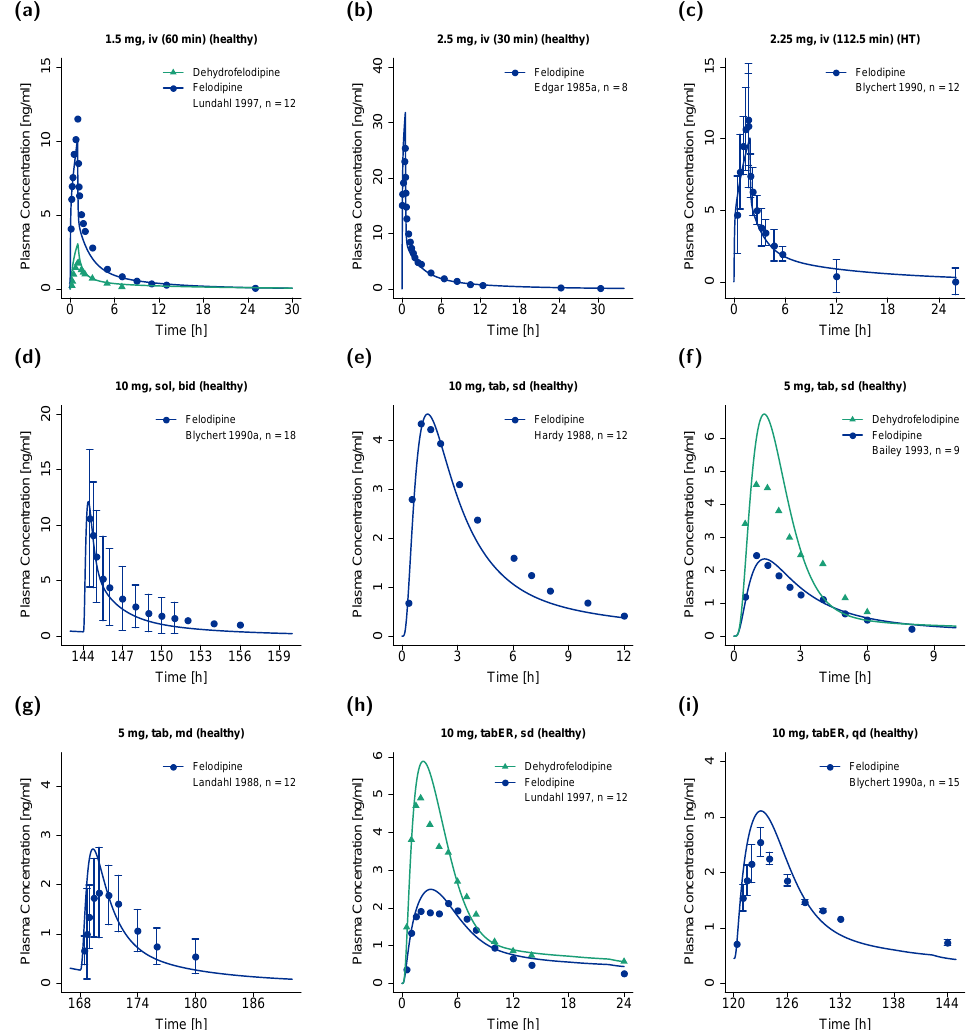
Figure 2. Predicted plasma concentration–time profiles of felodipine after administration as 1 ( a – c ) intravenous infusion, ( d ) oral solution, ( e – g ) conventional tablet, or ( h , i ) extended-release tablet in comparison to observed data [11,35,45,47,48,51,71]. Observed data are shown as dots (felodipine) and triangles (dehydrofelodipine) ± standard deviation (if available); model predictions are shown as lines (blue: felodipine, green: dehydrofelodipine). bid: twice daily, HT: hypertensive, iv: intravenous, n: number of individuals, sd: single dose, sol: solution, tab: tablet, tabER: extended-release